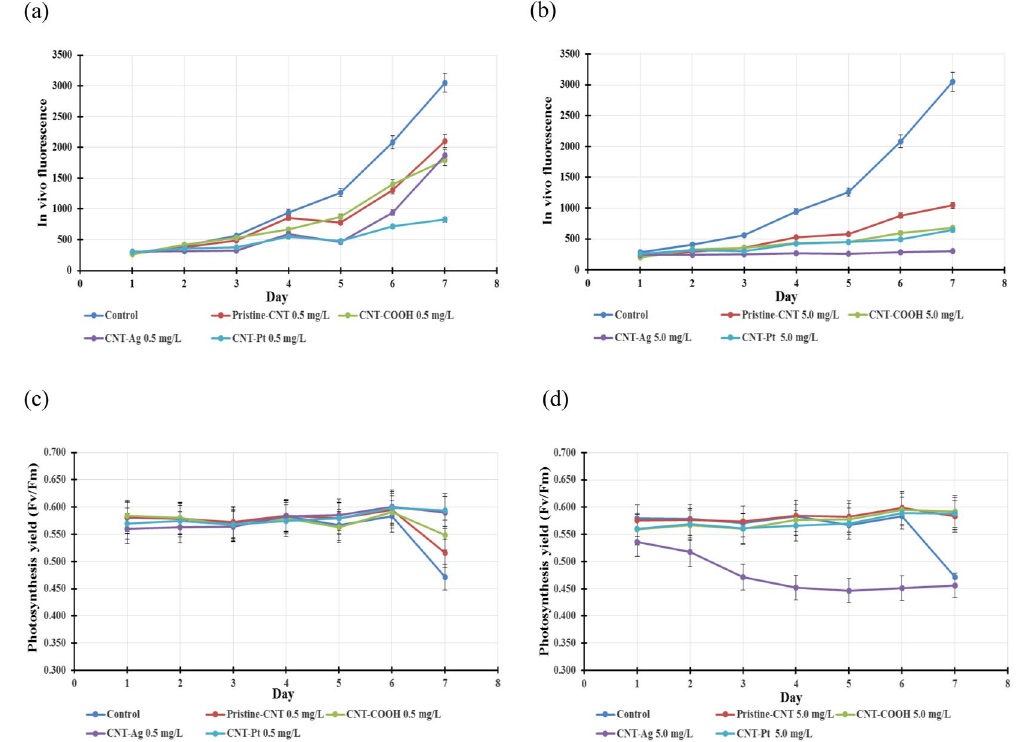
Figure 3. Growth curves of C . reinhardtii exposed to pristine and functionalized CNT. at concentrations of ( a ) 0.5 mg/L and ( b ) 5.0 mg/L. The photosystem II (PSII) quantum yield efficiency (Fv/Fm) of C . reinhardtii exposed to pristine and functionalized-CNT at concentrations of ( c ) 0.5 mg/L and ( d ) 5.0